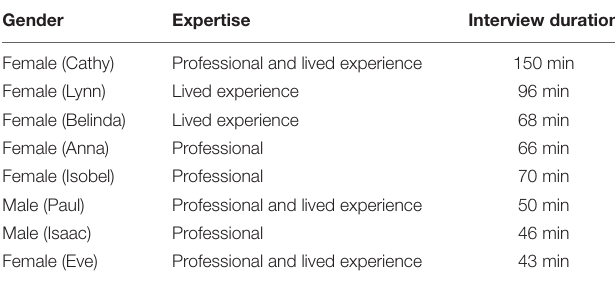
TABLE 2 | Interviewees by gender, expertise and interview